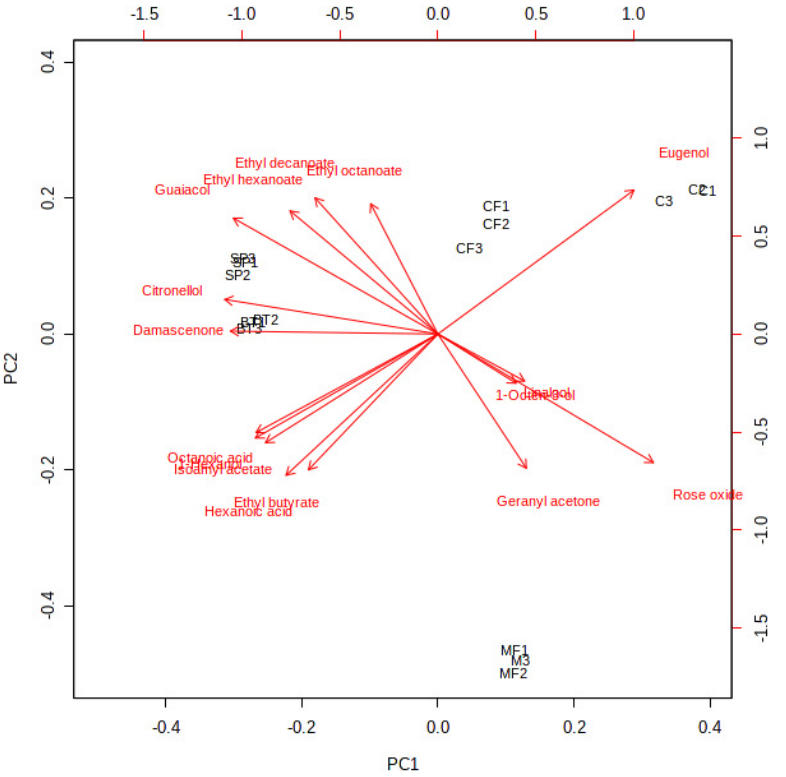
Figure 2. Principal component analysis of volatile compounds (OAV > 1) in wine samples with different clarification treatments.